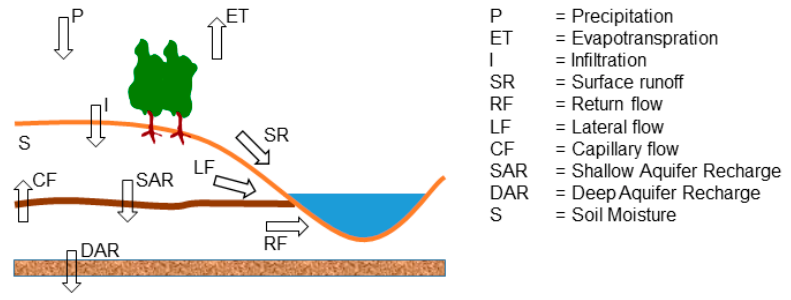
Figure 5. Schematic representation of hydrological cycle elements in SWAT.